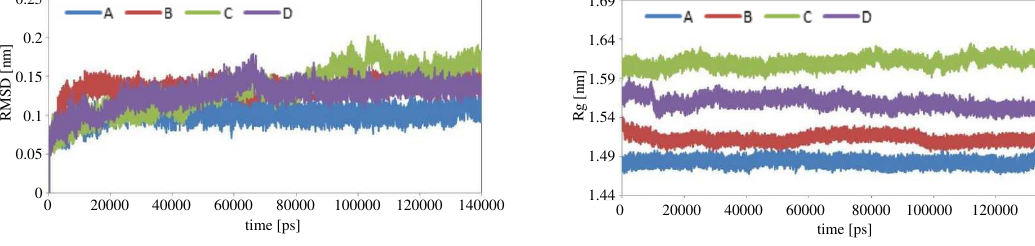
Figure 2: C α -RMSD values (nm) versus time (ps) for simulated systems defined as A , B , C and D .